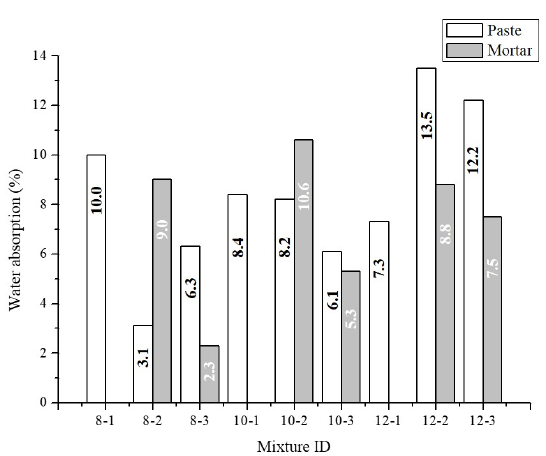
Figure 7. Water absorption of alkali-activated